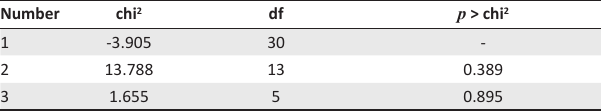
TABLE A1: Hausman tests of independence of irrelevant alternatives assumption. Number chi